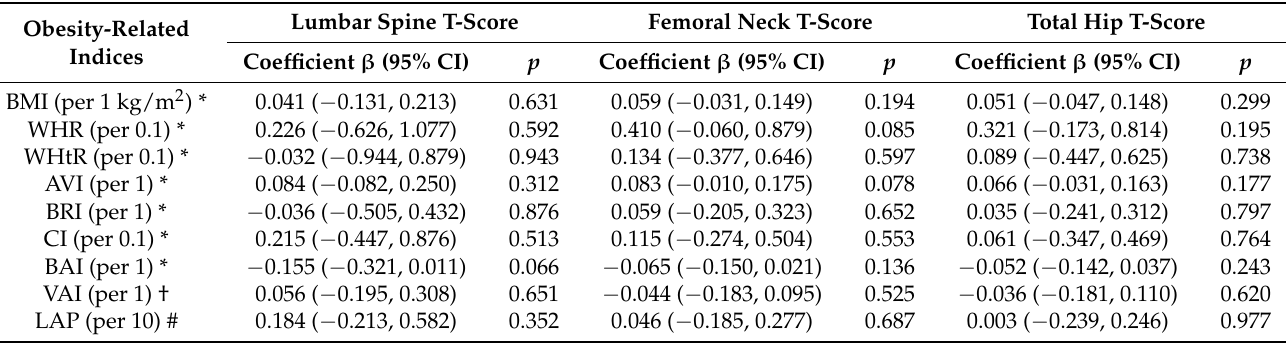
Table 4. Association between obesity-related indices and BMD T-score using multivariable linear regression analysis in patients without MetS ( n =